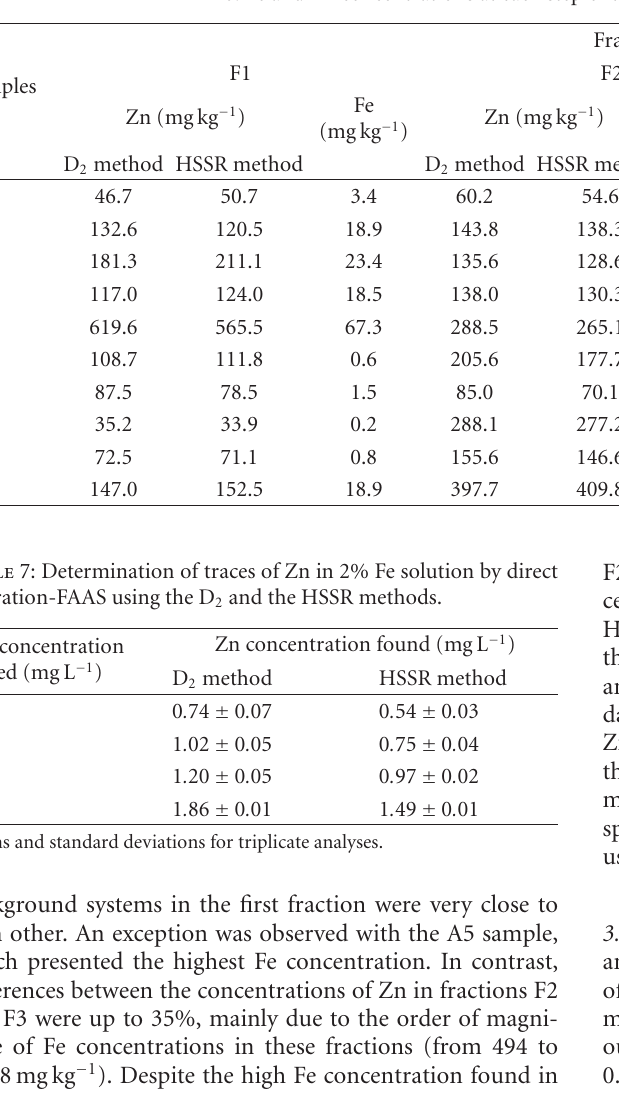
Table 6: Fe and Zn concentrations at each step of the SM&T sequential extraction procedure.